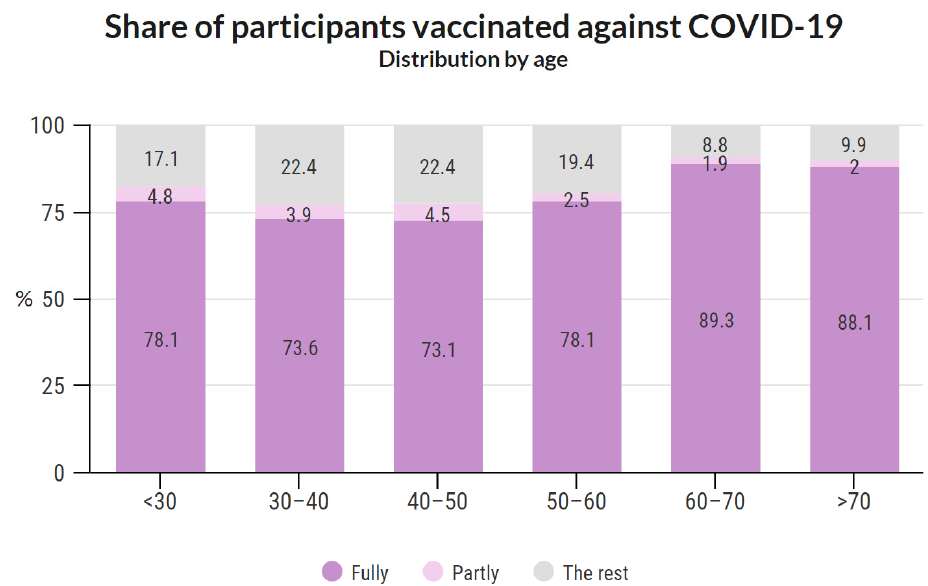
Figure 5. Share of participants vaccinated against COVID-19 based on age.